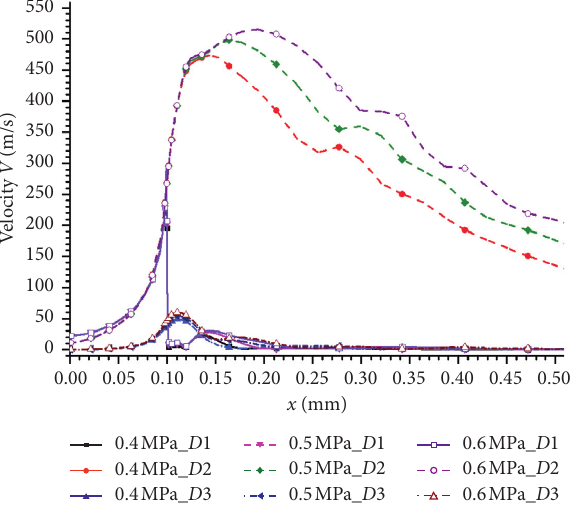
Figure 8: Curves of the velocity of the gas film at different p